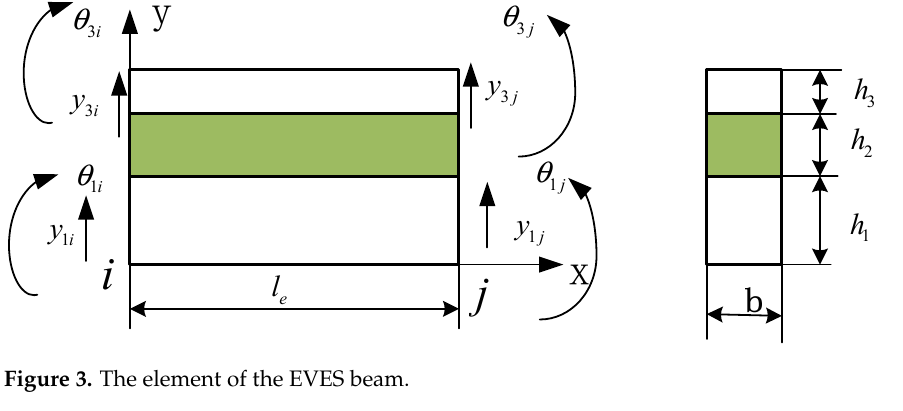
Figure 3. The element of the EVES beam.